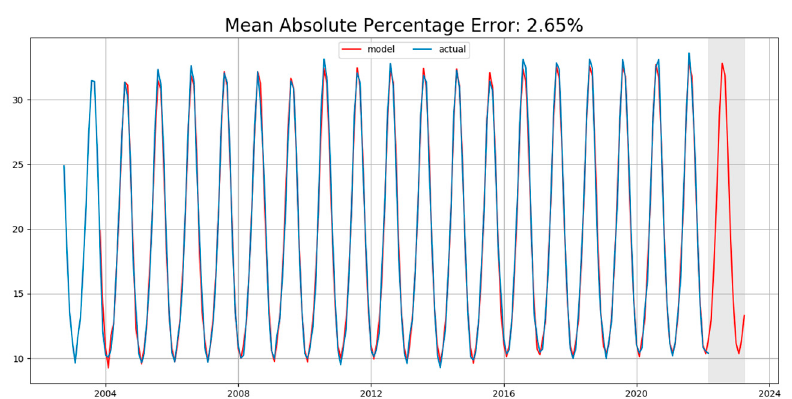
Figure 10. Residual test.